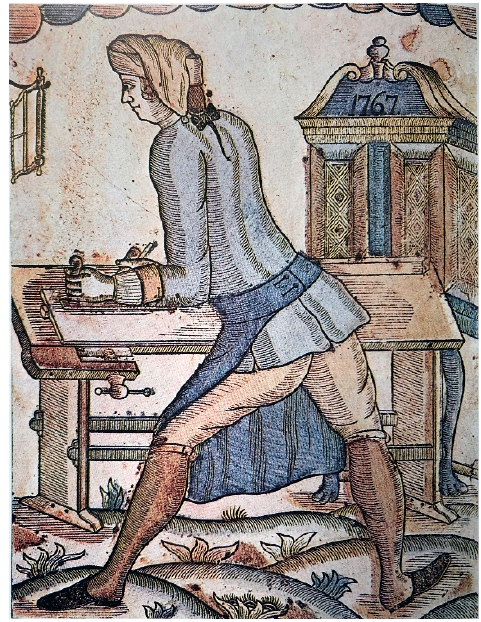
Figure 14. Thomas Larsen Borup, Cabinetmaker at his workbench , 1767. Woodcut.